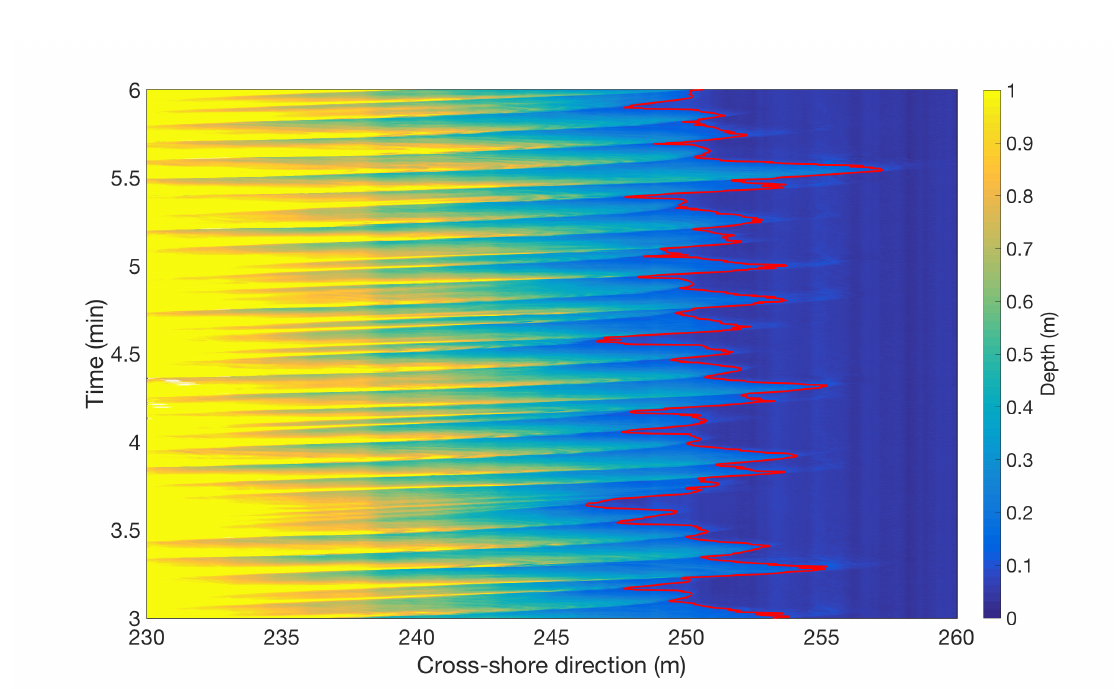
Figure 3. LiDAR scanner flow depth measurement using a threshold depth of 10